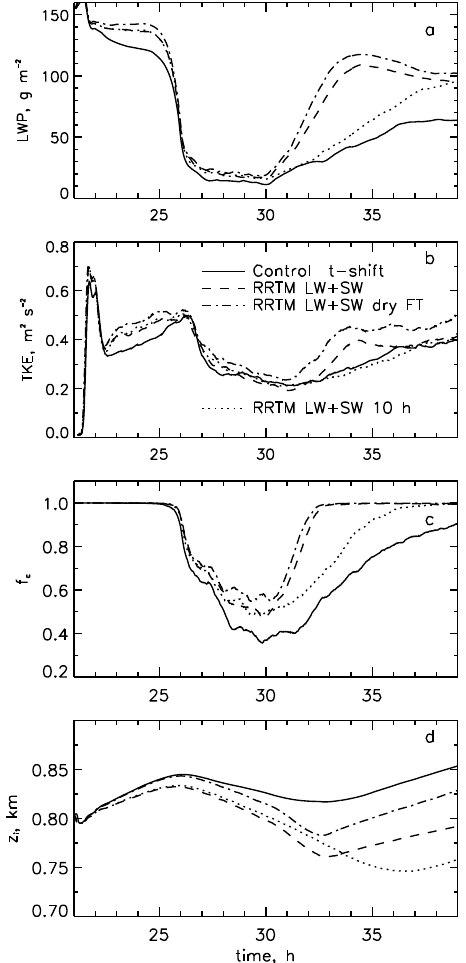
Figure 12. Perspective of different parameters controlling recovery. Solid line: control simulation with time shift such that N(t) time series coincide; dashed line: RRTM simulation as in Fig. 6b; dot- ted line: same as dashed line but with N recovering to 90mg − 1 over 10h; dash-dotted line: RRTM simulation as in Fig. 6b but with drier free troposphere imposed above model domain top. Minimum N = 5mg − 1 in all cases. Slow replenishment of N retards cloud recovery while stronger radiative forcing enhances